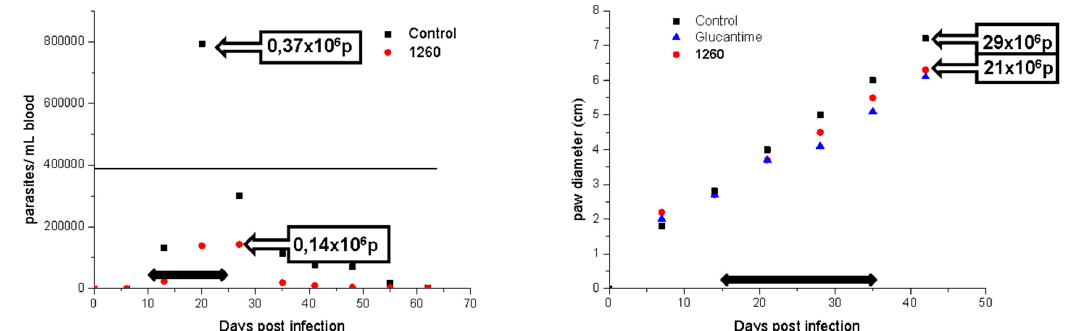
Figure 5. In vivo efficacy of compound 8 in mice models for Chagas disease (left) and Leishmaniasis (right). The black arrow indicates the treatment period where a dose of 50 mg/kg was administered once a day. In the left graph, the parasite number per mL of blood (parasitemia) is shown at different days post-infection. The black line indicates 50% of parasitemia relative to the control without treatment. In the right graph, the paw diameter is represented over time post-infection and the number of parasites in the lesion at the end of the experiment is indicated.